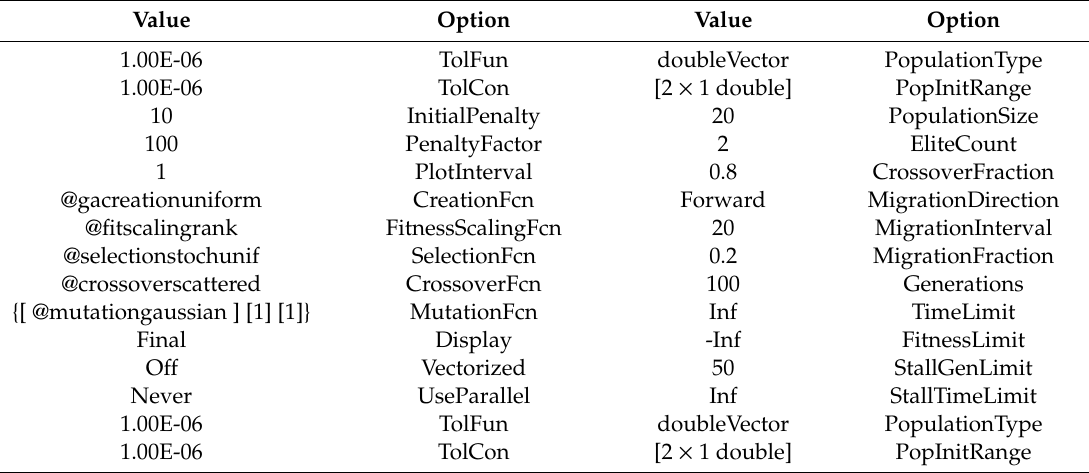
Table 2. Parameters of genetic algorithm (GA) coded in this study by using MATLAB